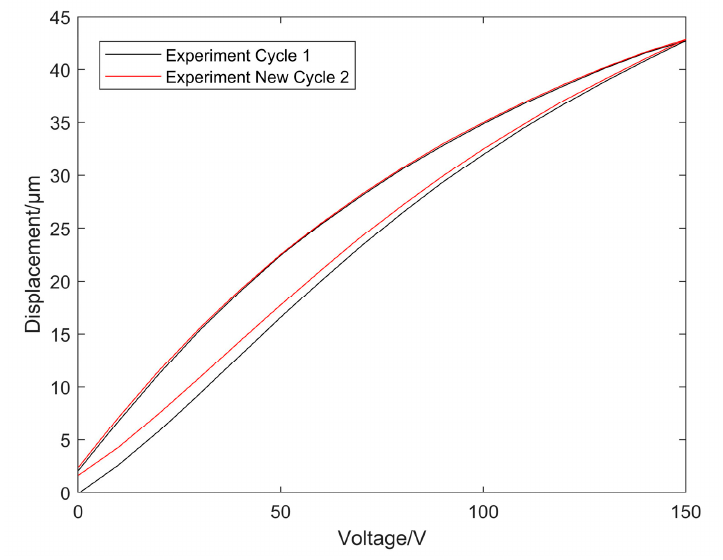
Figure 10. Voltage-displacement curves for the first cycle and the new second cycle.